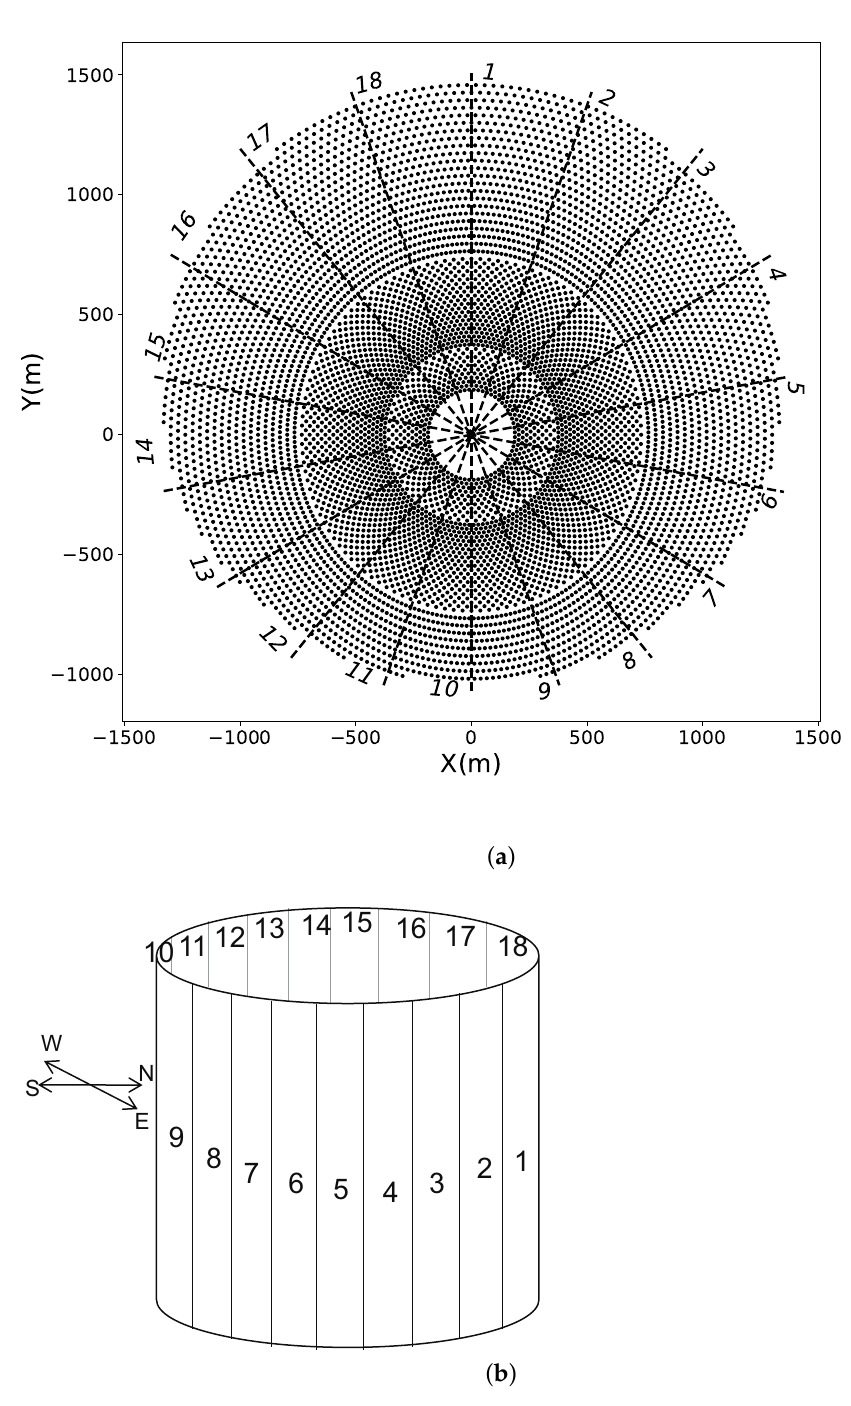
Figure 1. ( a ) The heliostat field layout [30]. The north is indicated as the positive direction of the Y-axis, and the east is indicated as that of the X-axis. ( b ) A schematic diagram of the external cylindrical receiver. The number of the panels corresponds to that of the sector